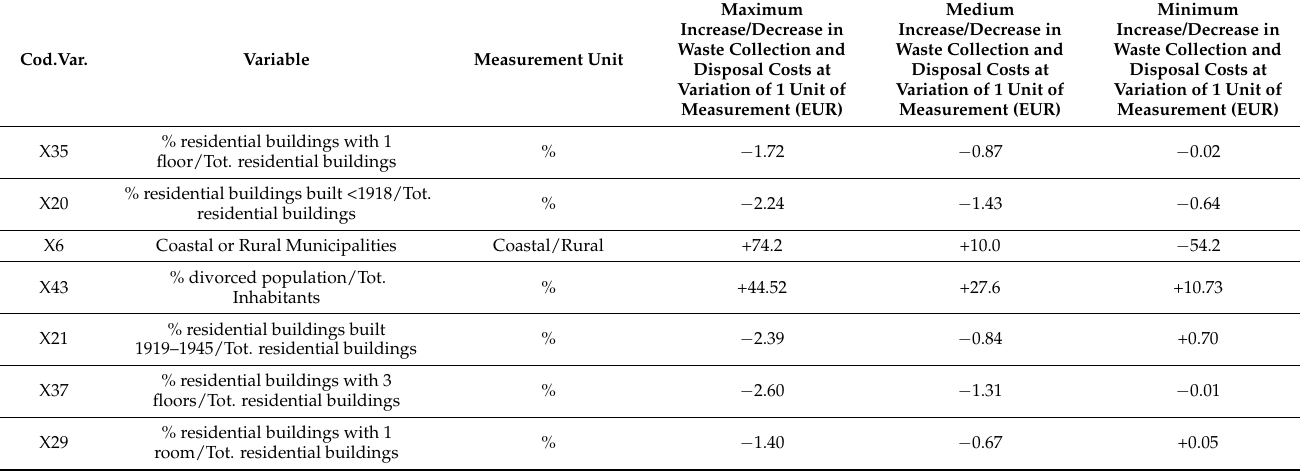
Table 3. MSW management costs: Range of the average increase/decrease per unit of measurement of each of the 15 variables shown in Figure